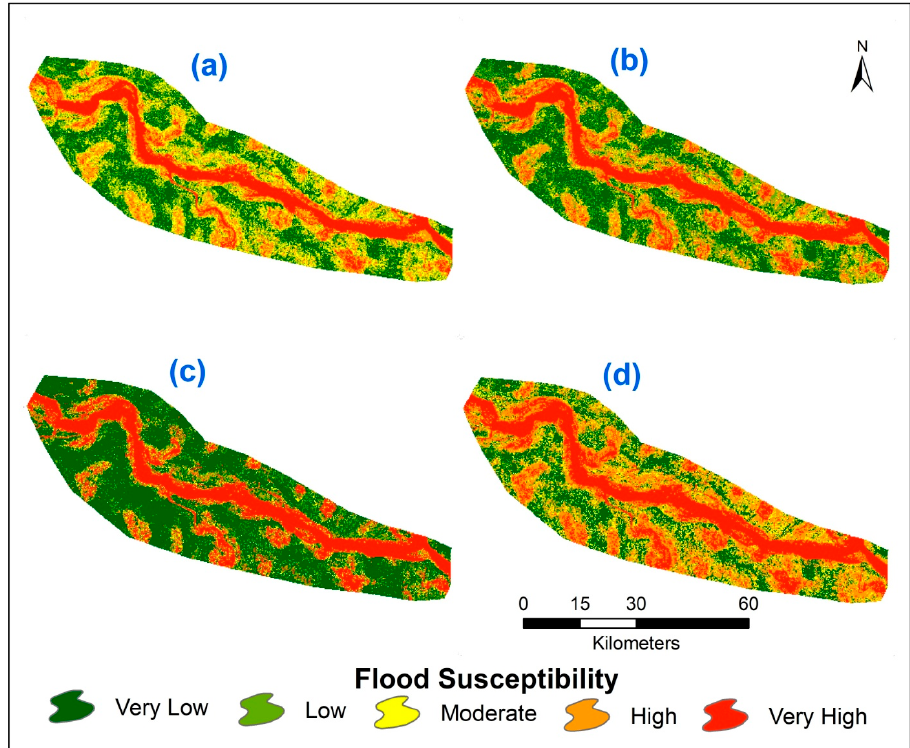
Figure 4. Flood susceptibility assessment using ADT-ICO ( a ), NB-ICO ( b ), ANN-ICO ( c ), and DLNN-ICO ( d ).